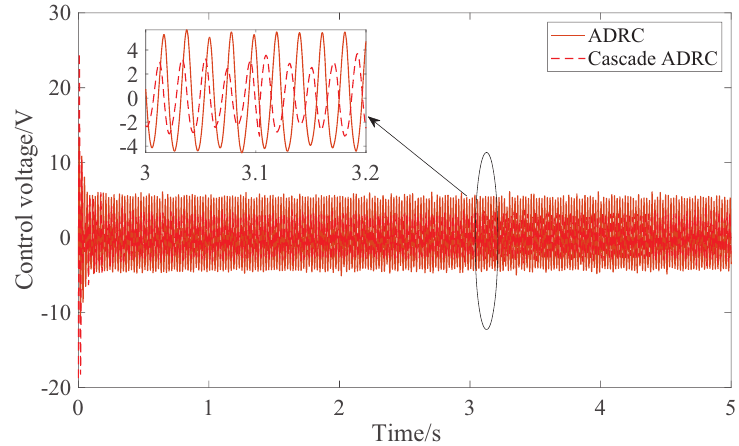
Figure 8. Experimental control–voltage